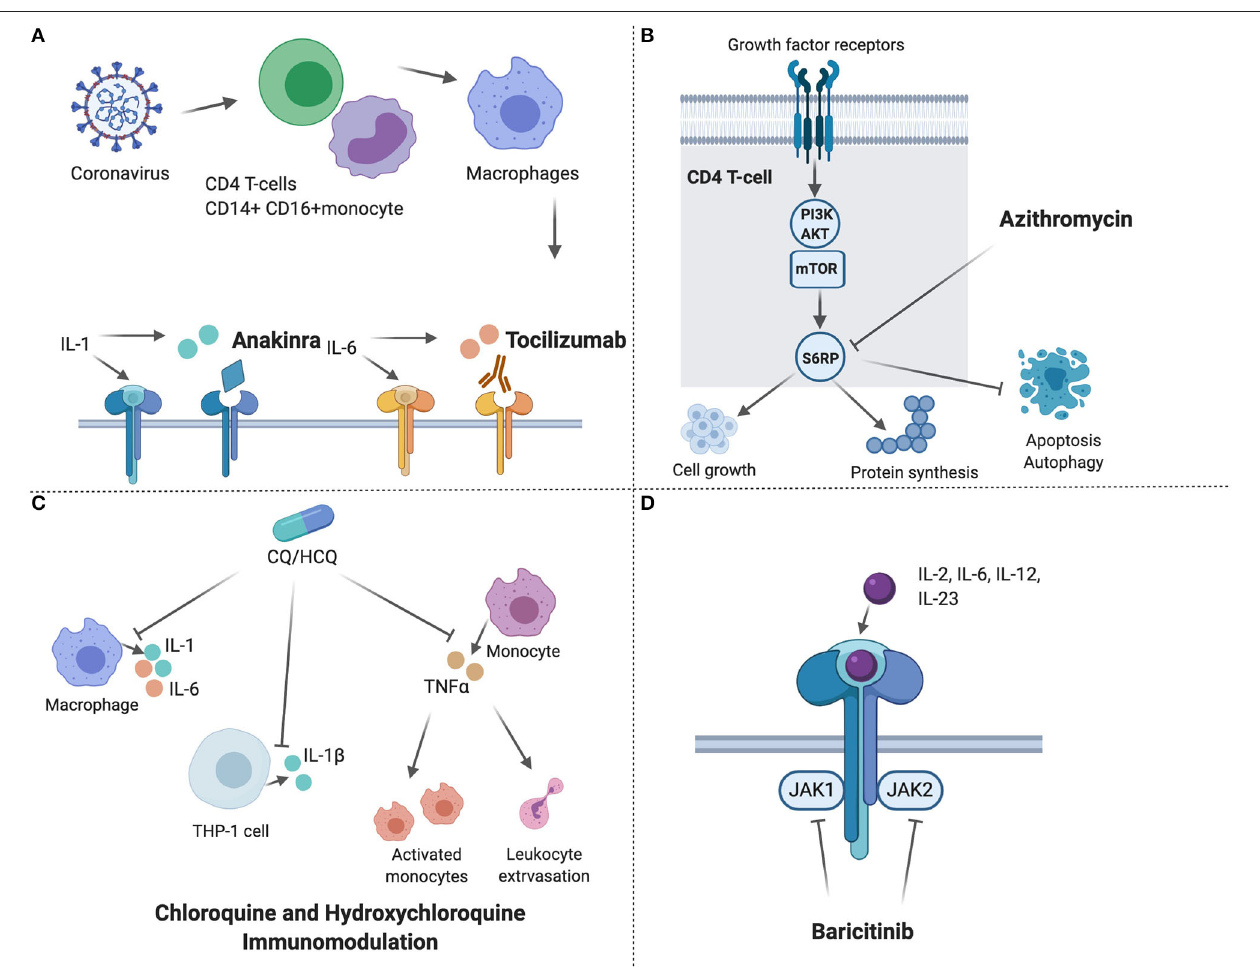
FIGURE 4 | Host targeted drugs with potential use for Coronavirus disease-19 and their proposed mechanism of action. (A) Anakinra, is a human Interleukin 1 receptor antagonist, and tocilizumab is a monoclonal antibody that binds to IL-6 receptors (132, 133); (B) Azithromycin inhibits phosphorylation of S6RP in the mTOR pathway in T cells, which leads to reduced cell growth, protein synthesis, and increased apoptosis and autophagy of T cells ( 134); (C) Immunomodulating effects of chloroquine and hydroxychloroquine, which inhibits the production of IL-1, IL-1 β , IL-6, and TNF α (121, 135, 136); (D) Baricitinib inhibits the activation of different interleukins and growth factors through inhibiting the JAK1 and JAK2 on the cytokine receptor ( 137–139). The figure was created with